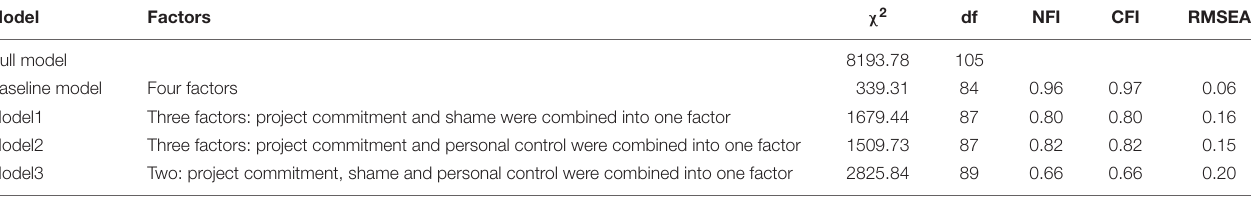
TABLE 2 | Means, standard deviations, reliabilities, and correlations. Variable